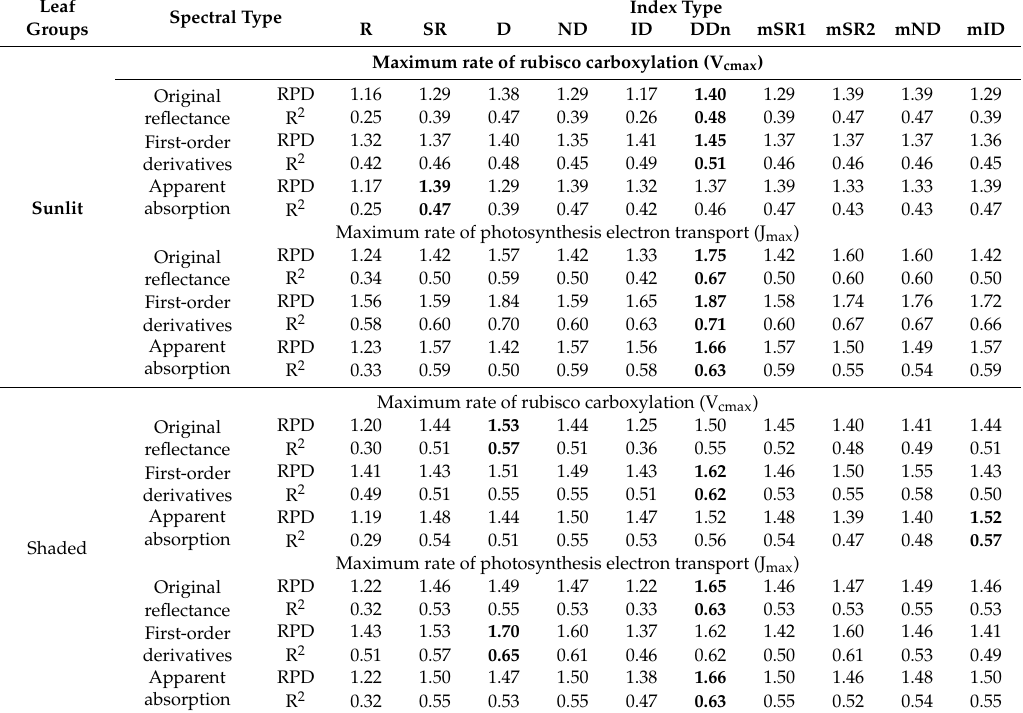
Table 6. RPD and R 2 from developed indices using di ff erent leaf group